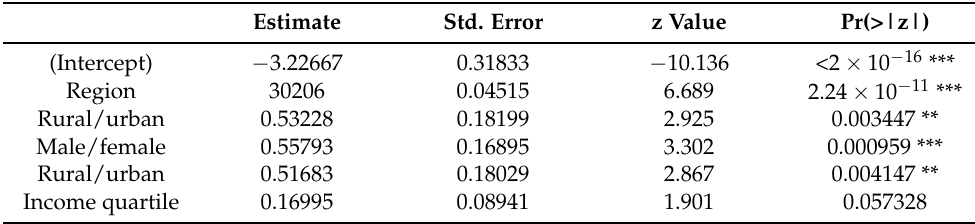
Table 5. Coefficients for best logistic regression model including all variables in Table 2, excluding mother’s education and electricity.